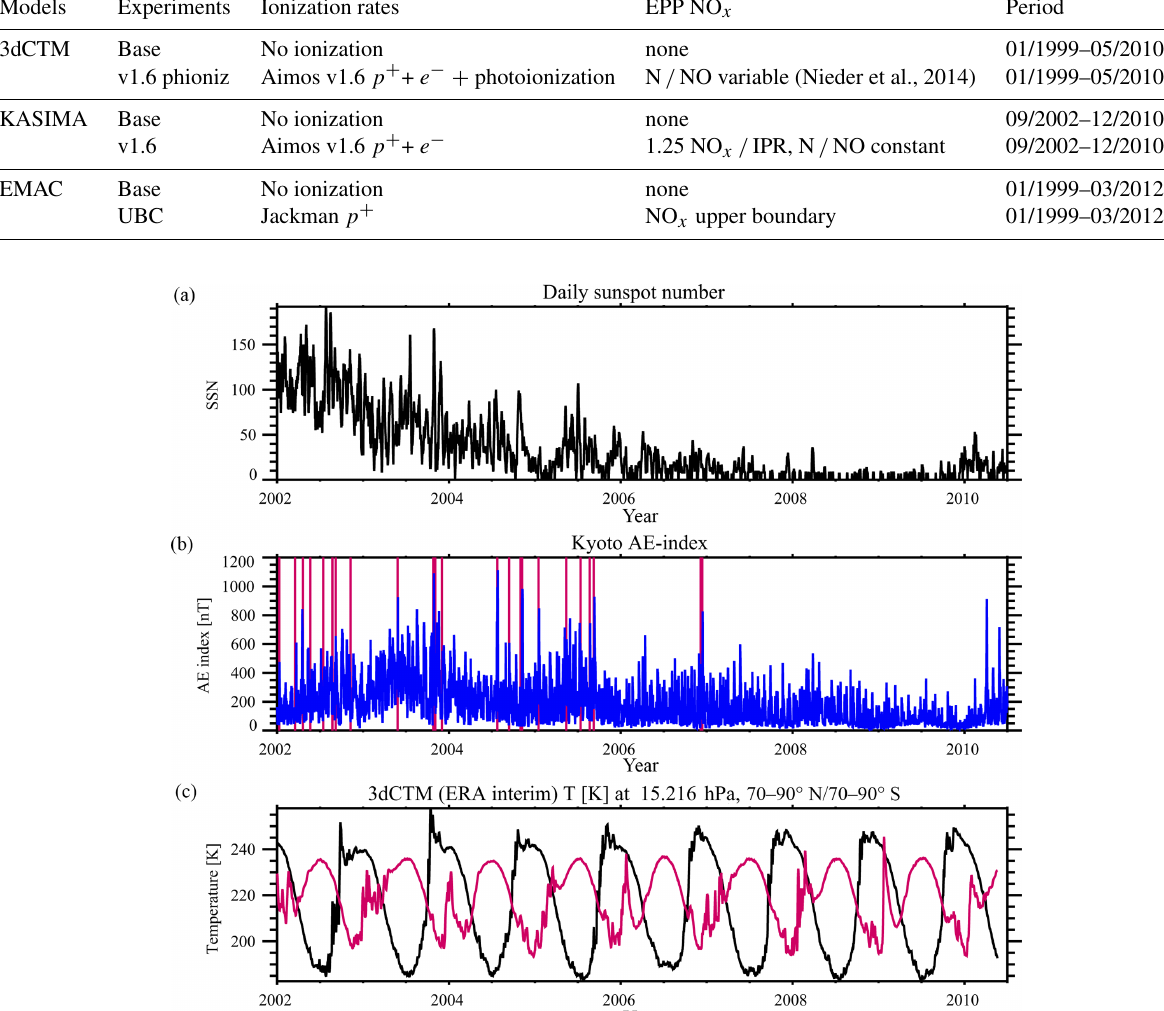
Table 1. Properties of the model experiments used in this study. Models